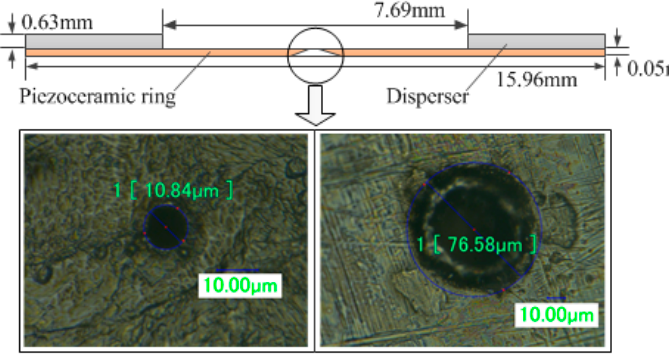
Figure 6. The structure and parameters of the atomizer piece.